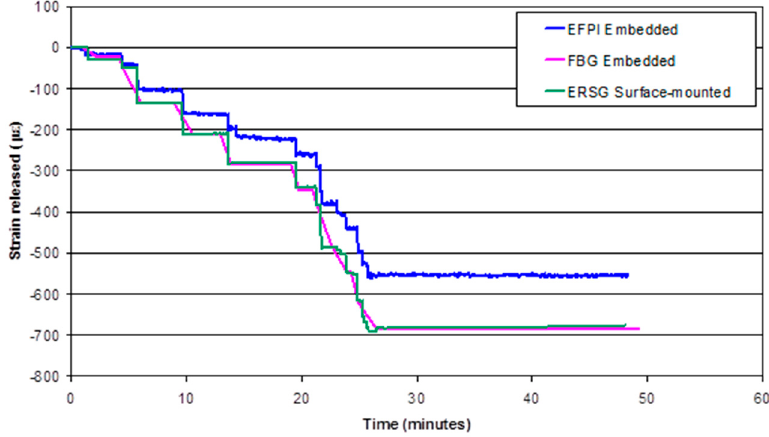
Figure 19. Strain data from the EFPI, FBG and ERSG sensors when a composite (Panel code UP9_14kN), with a previously applied pre-stress of 108 MPa, was unloaded from the pre-stressing rig in a stepwise manner.